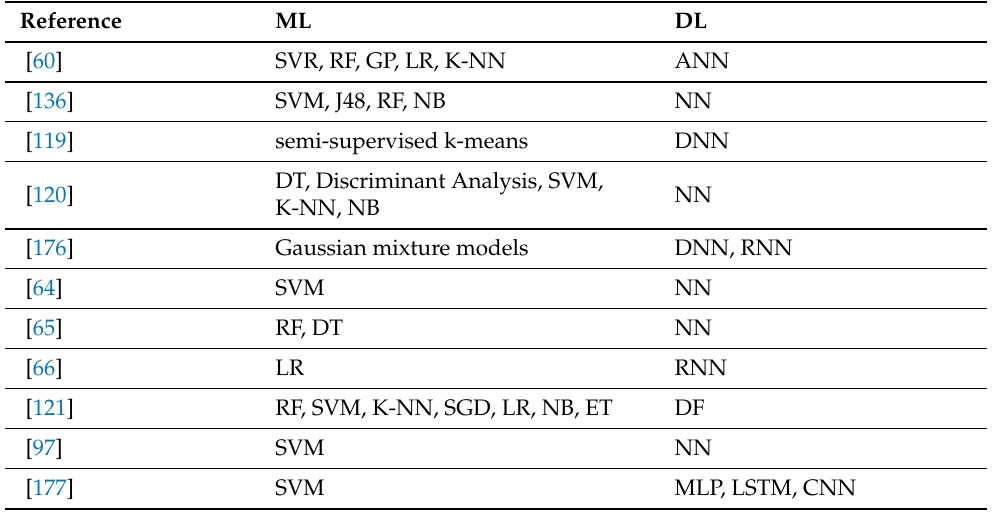
Table 7. Various ML and DL techniques used in context-aware scenarios for sensor networks.